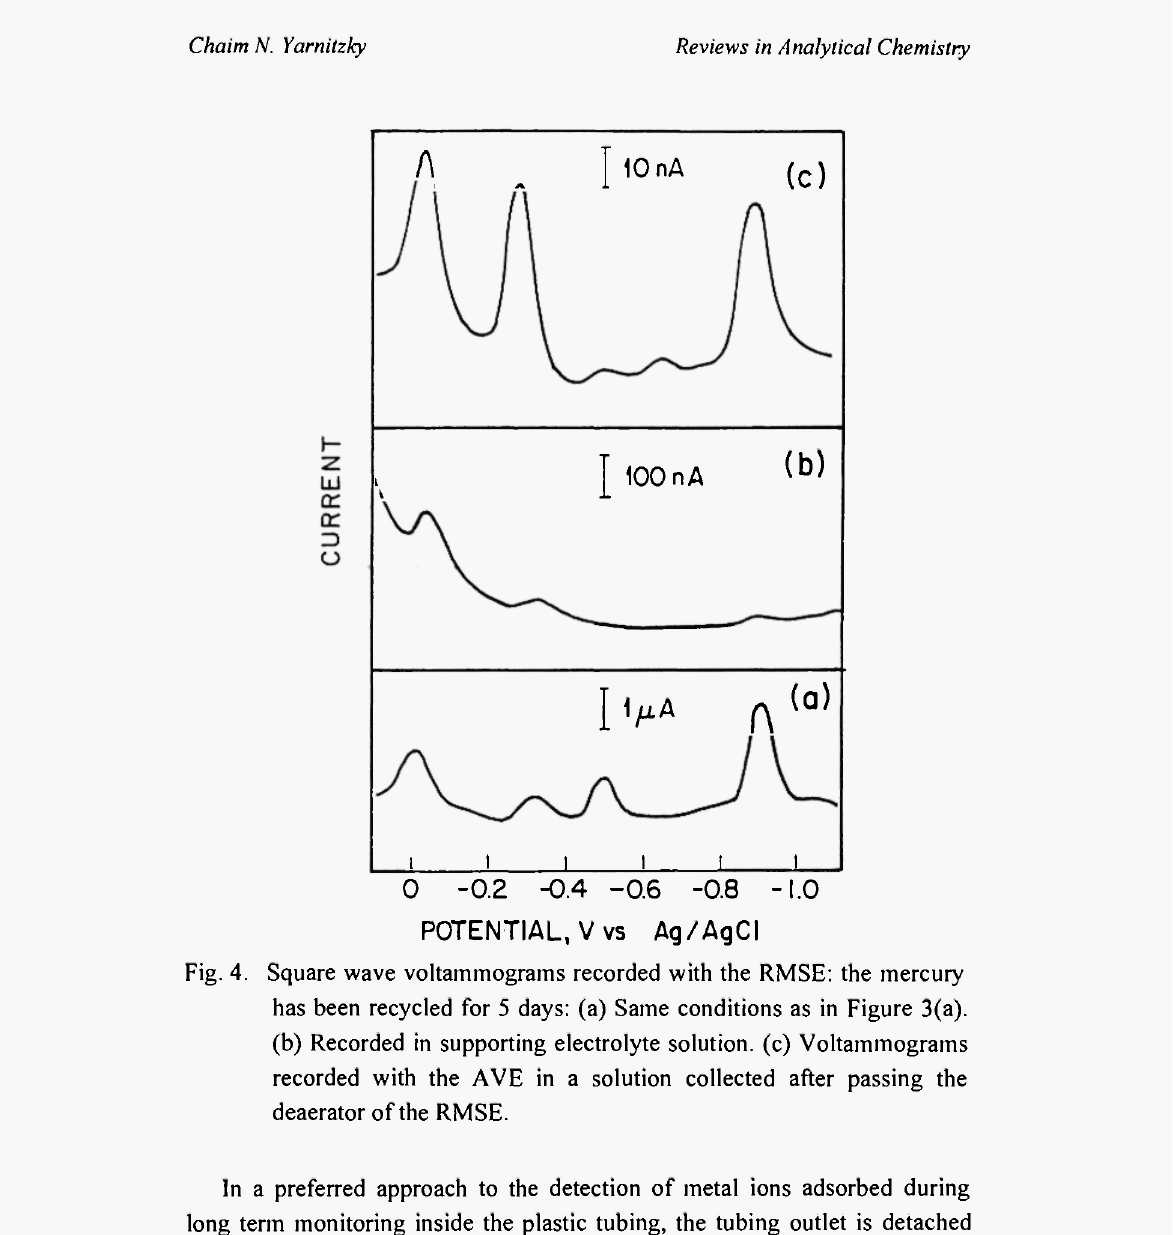
Fig. 4. Square wave voltammograms recorded with the RMSE: the mercury has been recycled for 5 days: (a) Same conditions as in Figure 3(a). (b) Recorded in supporting electrolyte solution, (c) Voltammograms recorded with the AVE in a solution collected after passing the deaerator of the